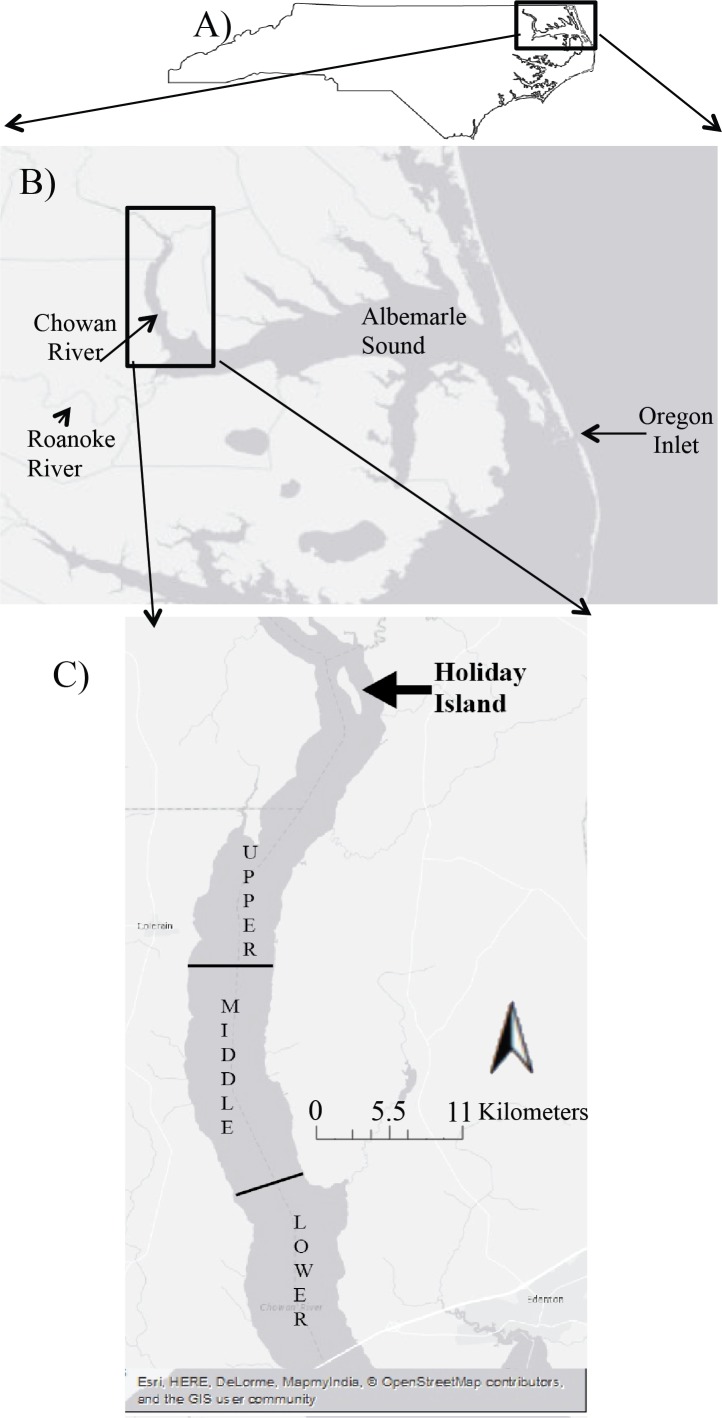
The overview of Albemarle Sound in North Carolina (A). The close up view of the location for two main tributaries (Chowan and Roanoke Rivers), and the Albemarle Sound in North Carolina (B). The three sections used to collect zooplankton on the Chowan River (C).Map data: ESRI, HERE, DeLorme, MapmyIndia, OpenStreetMap contributors, GIS user community.